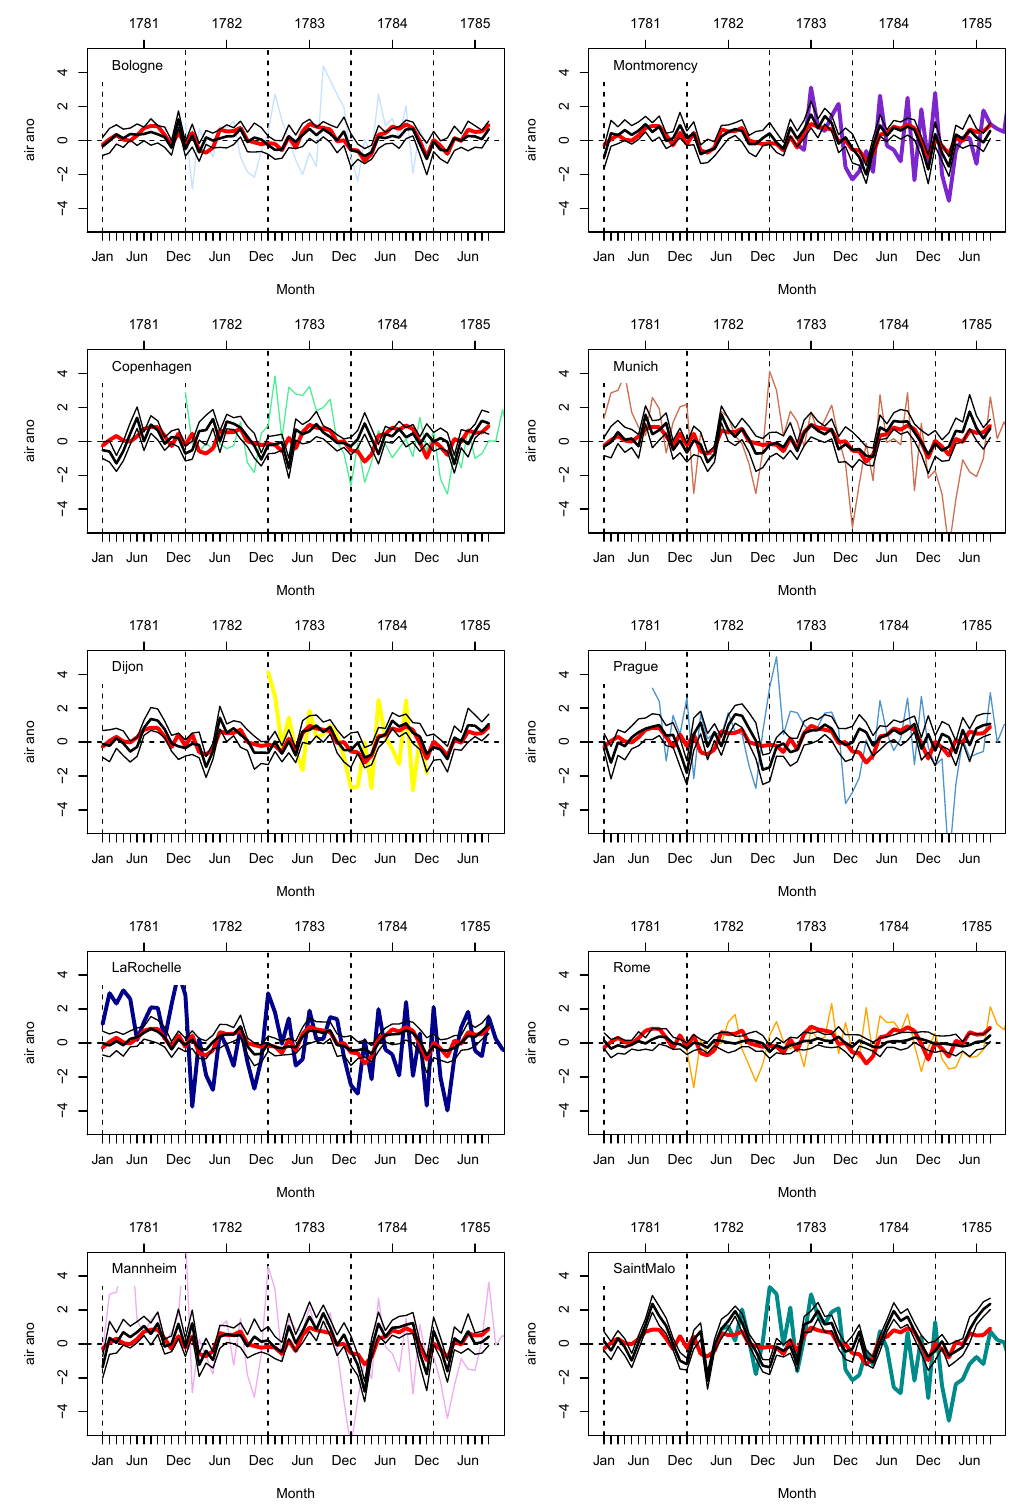
Fig. 6. Monthly temperature anomalies in Europe from historical records (in K) with respect to an average seasonal cycle (continuous coloured lines). The thick black lines represent the temperature anomaly reconstructions for the grid cell closest to the indicated historical record. The thin black lines indicate the σ interval around the reconstruction. The red thick lines represent the average of the temperature anomaly reconstruction over France (same line for all